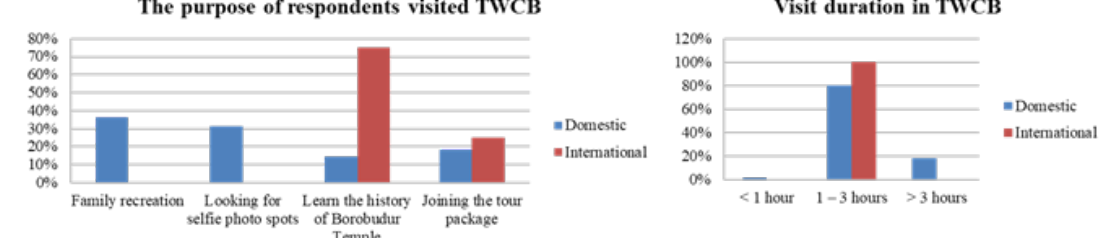
Fig. 4 The purpose of respondents visited TWCB and visit duration in